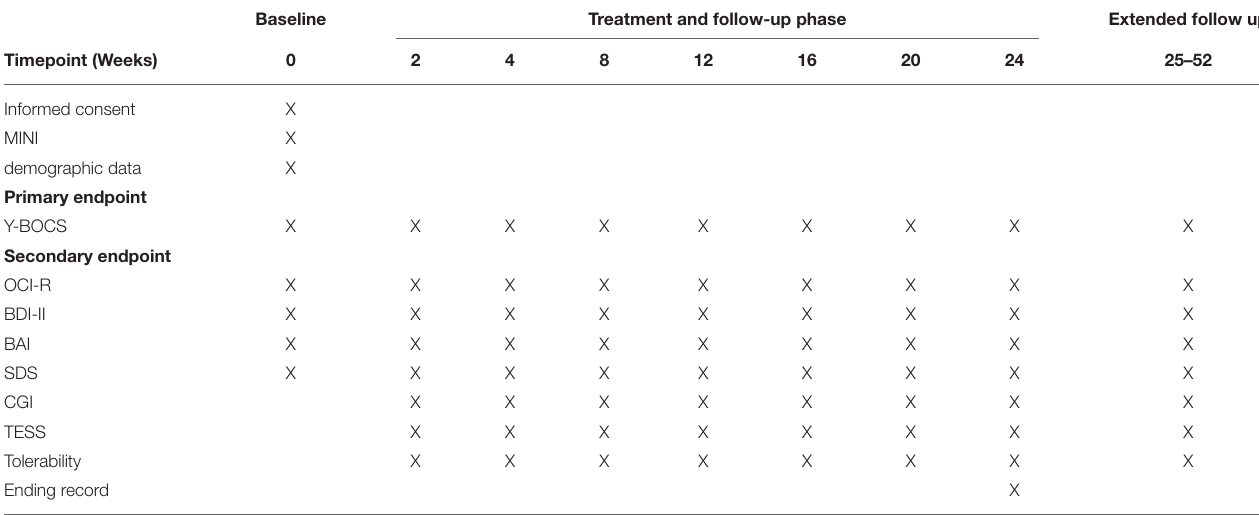
TABLE 1 | Timing of assessments and data collection.